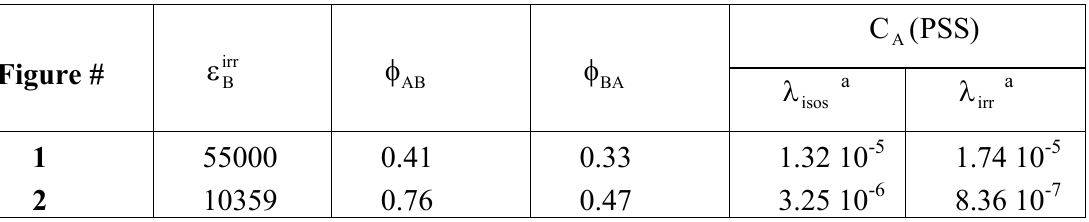
Table 4 : Spectroscopic and kinetic values of the unknown parameters calculated by the spectrokinetic method (Eqs. 24) using data of Table